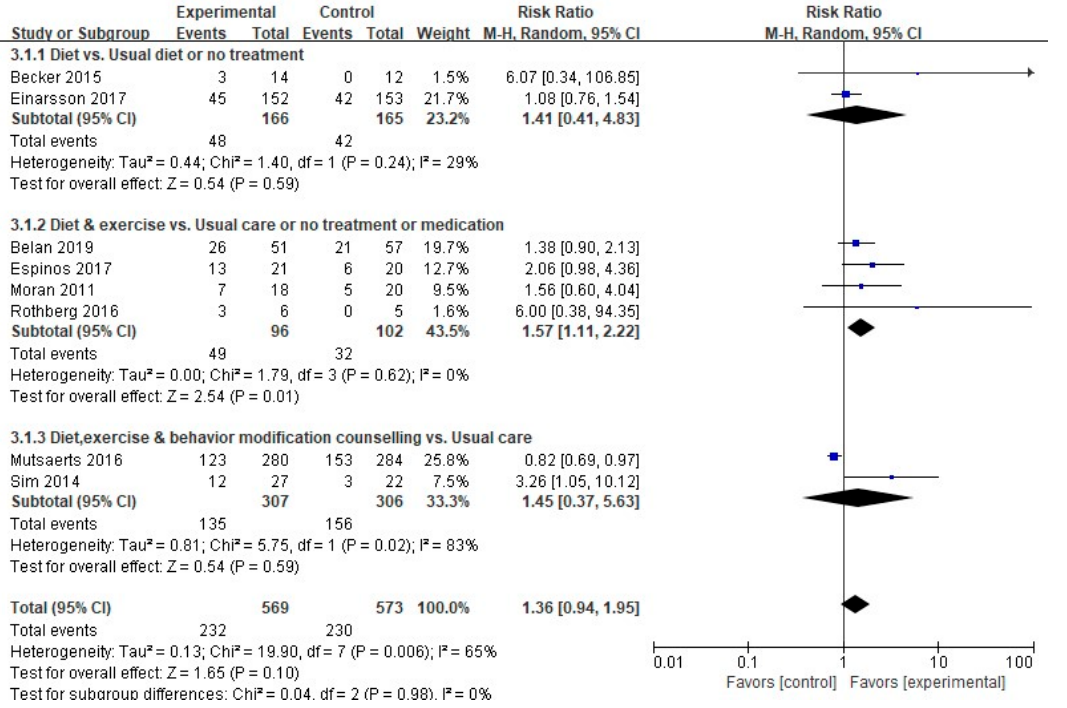
Figure 6. Forest plot of nonpharmacological interventions on the live birth rate. M-H, the Mantel-Haenszel method; Random, random effects model; CI, confidence interval.